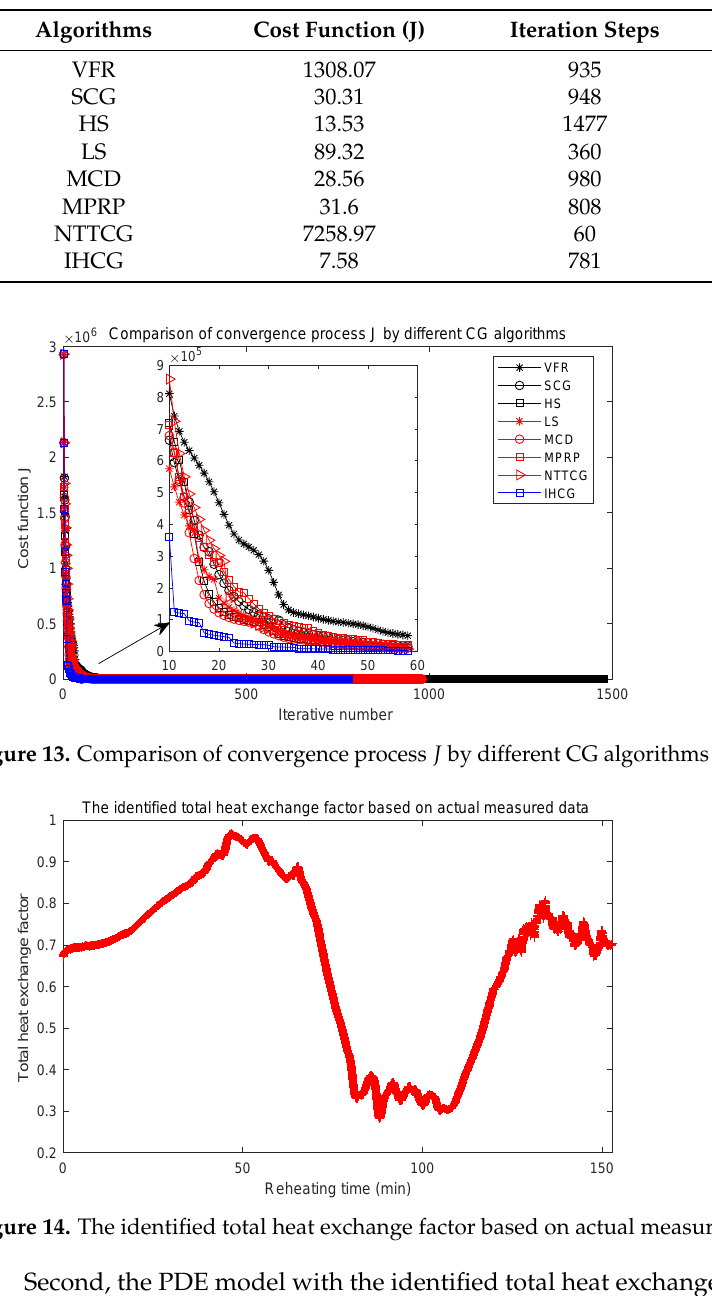
Table 4. Comparison of simulation performance by different CG algorithms with measured data.